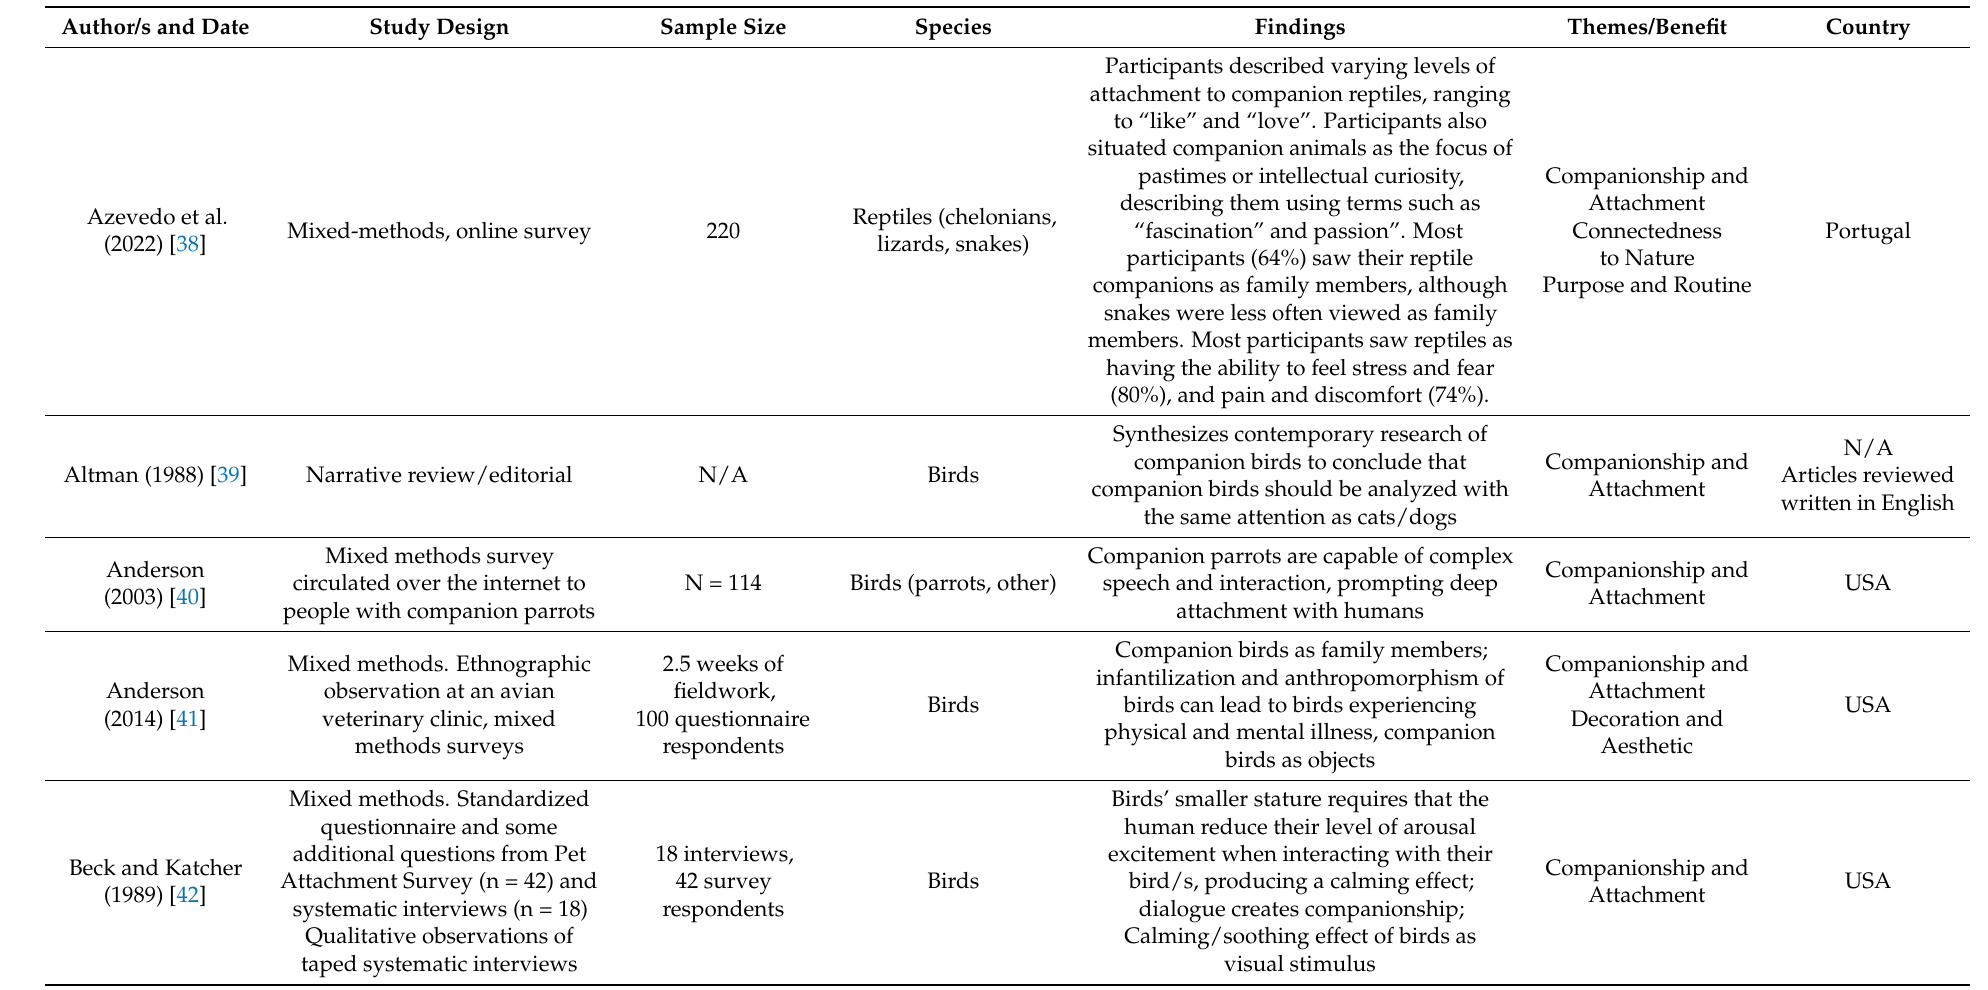
Table 1. Peer-reviewed studies included in the review listed in alphabetical